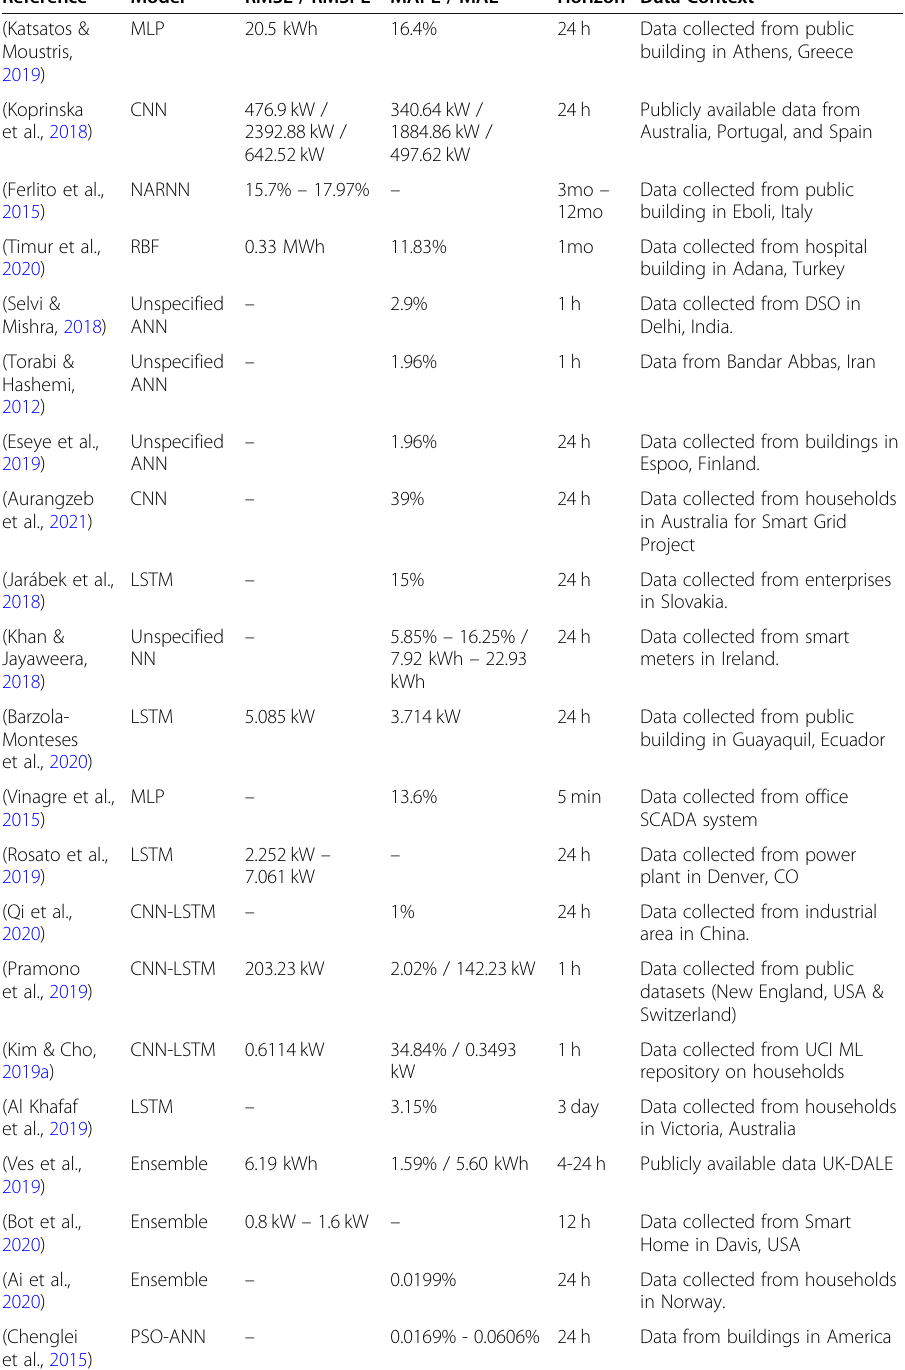
Table 4 Selected models including their performance and data source